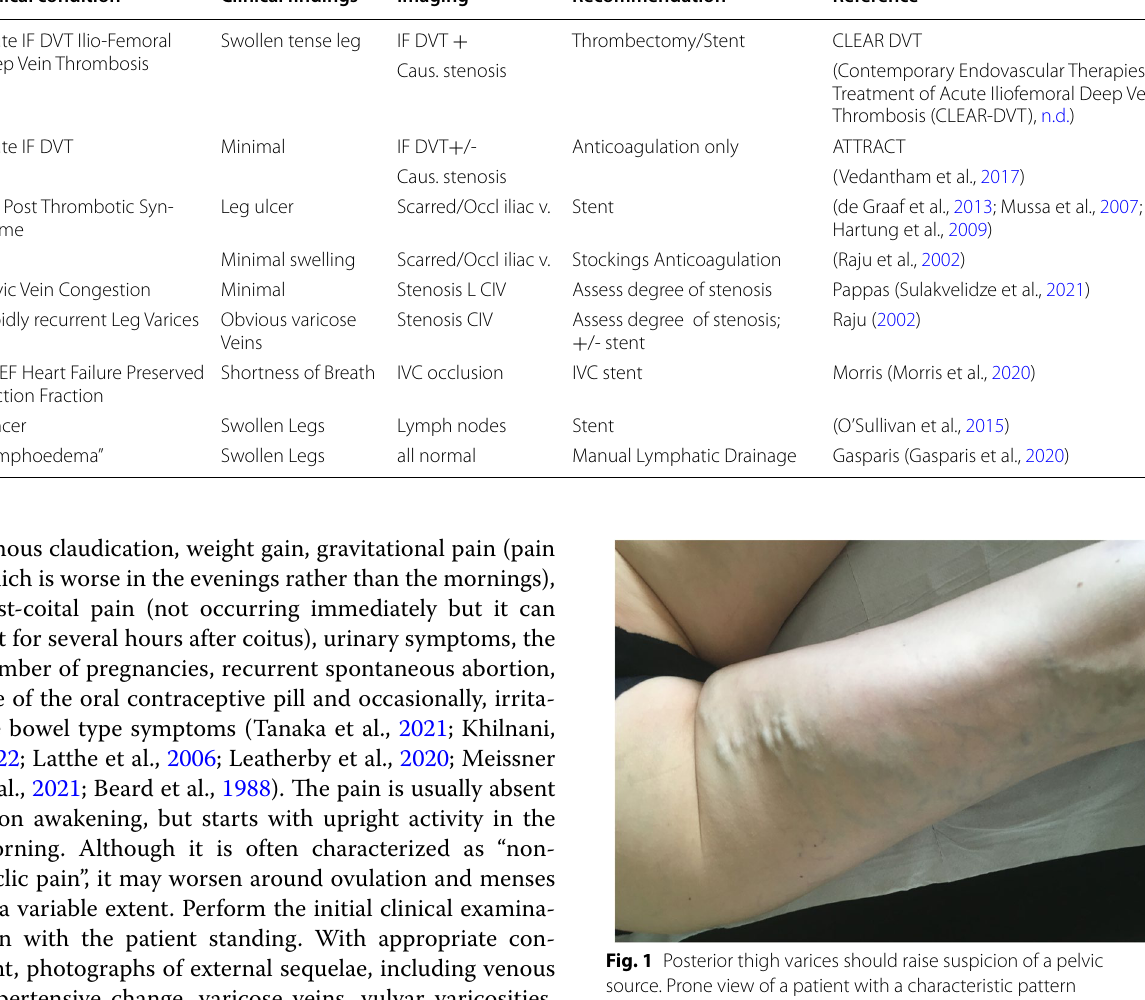
Table 1 Lower extremity venous stenting indications Clinical condition